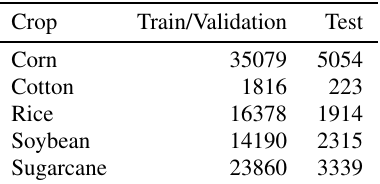
Figure 1. Proposed deep neural network architecture. The Red node corresponds to a noise generation layer. Blue nodes represent Long Short-Rerm Memory (LSTM) recurrent layers. Gray nodes represent dense, fully-connected layers. The green node represents a concatenation layer, which concatenates the intermediate representations from the dynamic and static paths. Numbers below node names represent shapes of input and output tensors. For example, x × y represents a x by y matrix, while single numbers represent line vectors. n corresponds to the crop cycle length (in months). This figure was extended from Oliveira et al. (2018).